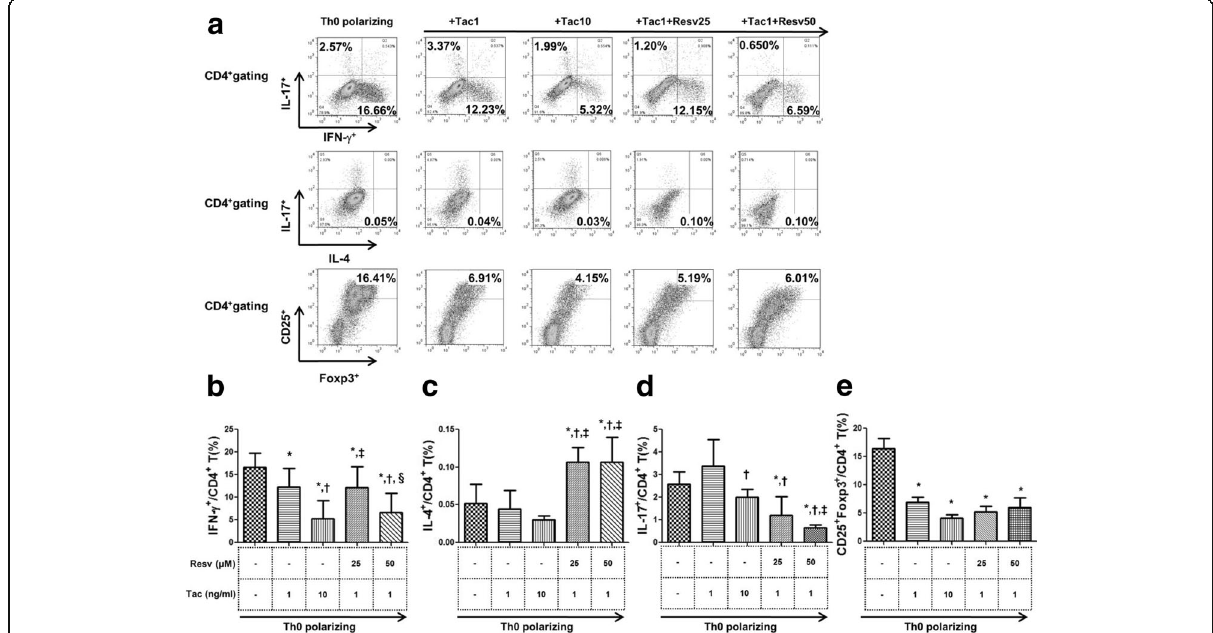
Fig. 1 The suppressive effects of Resv on the differentiation of CD4 + T cells into effector T cells. ( a ) Representative figure of flow cytometry using CD4 + T stained with anti-IFN- γ FITC, anti-IL-17 PE and anti-IL-4 APC. The effect of Tac with or without Resv on ( b ) Th1 (IFN- γ + /CD4 + T cells), ( c ) Th2 (IL-4 + /CD4 + T cells) ( d ) Th17 (IL-17 + /CD4 + T cells) and (e) Treg (CD25 + Foxp3 + /CD4 + T cells) under Th0 polarizing conditions. * P < 0.05 vs. Th0 polarizing † P < 0.05 vs. Tac 1 ng/mL group ‡ P < 0.05 vs. Tac 10 ng/mL group §P < 0.05 vs. Tac 1 ng/mL + Resv 25 μ M group. Resv, Resveratrol; Tac, tacrolimus; Treg, regulatory T